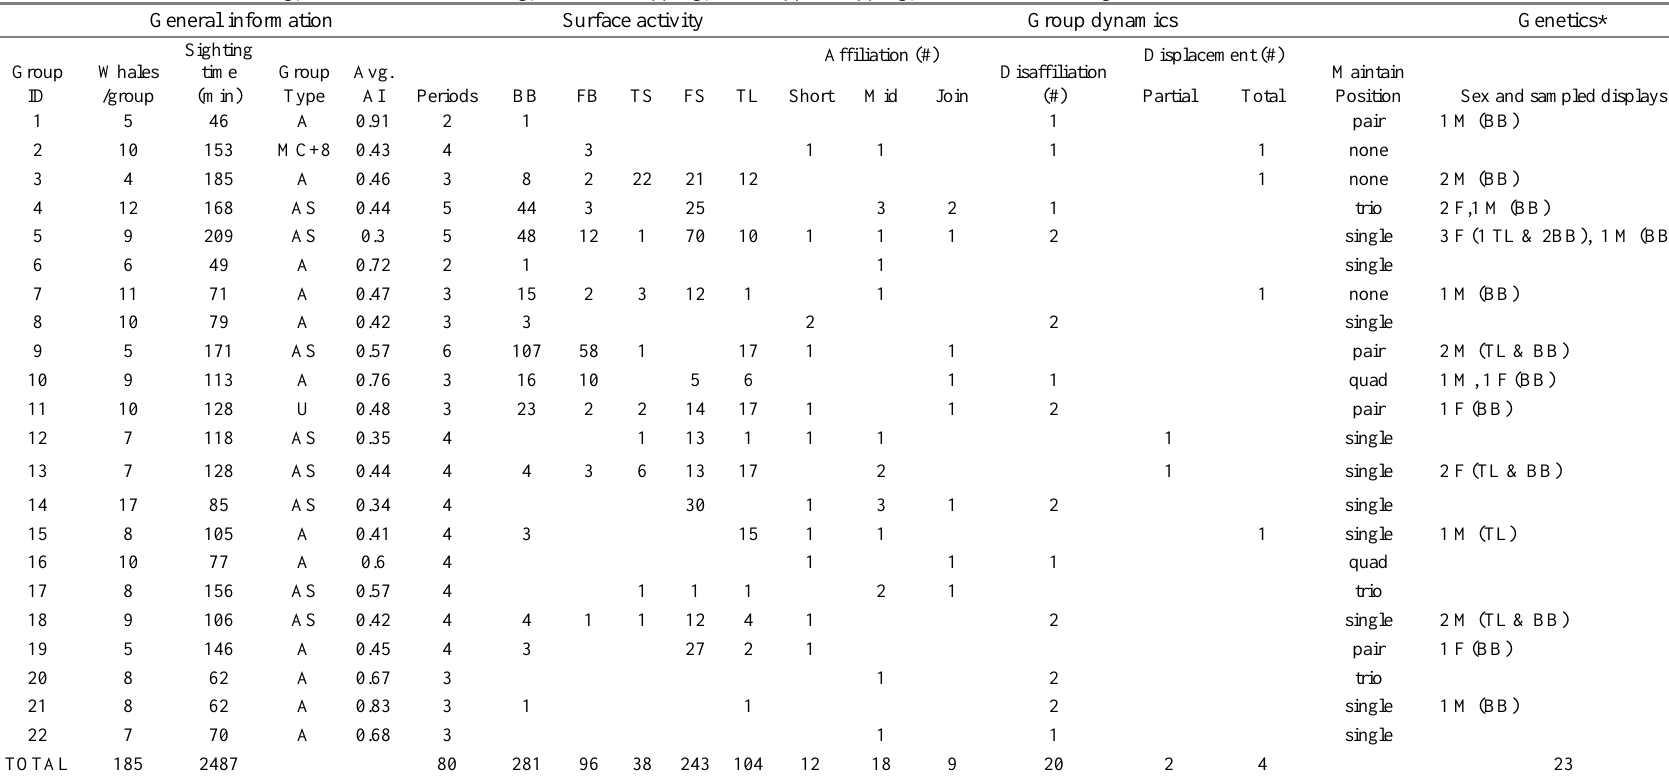
Information on sighting effort, group size and composition, surface activity, group dynamics and sex recorded in 22 competitive groups assessed off Ecuador. Surface displays include BB=backward breaching, FB = forward breaching, TS = tail slapping, FS = flipper slapping, and TL = tail